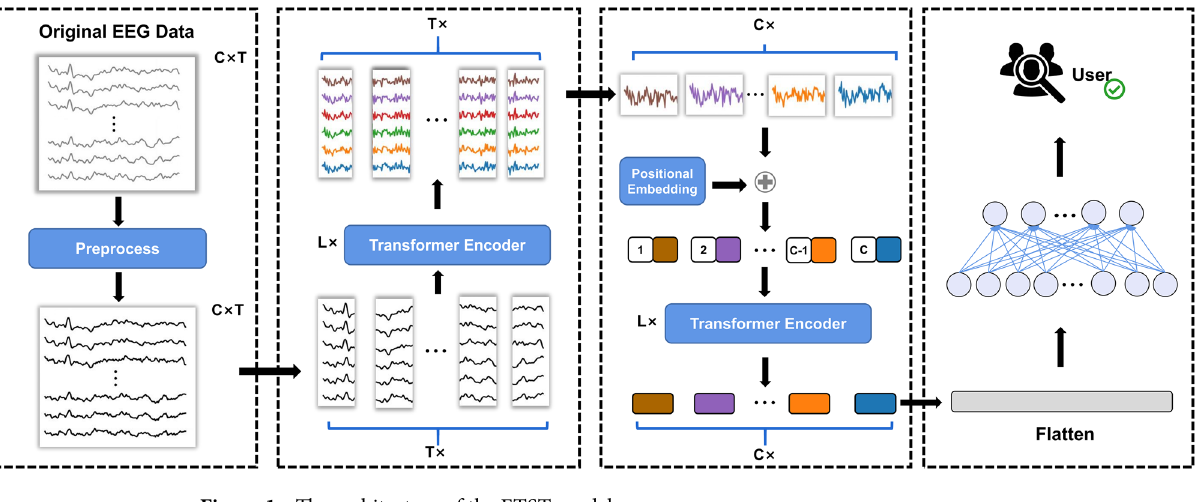
Figure 1. The architecture of the ETST